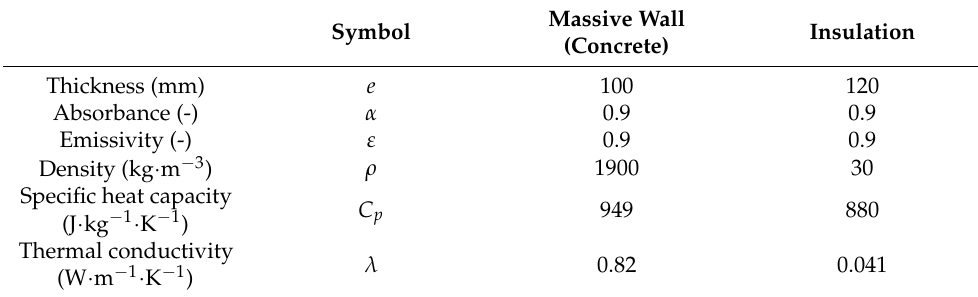
Table 3. Thermophysical properties of the opaque layers of the